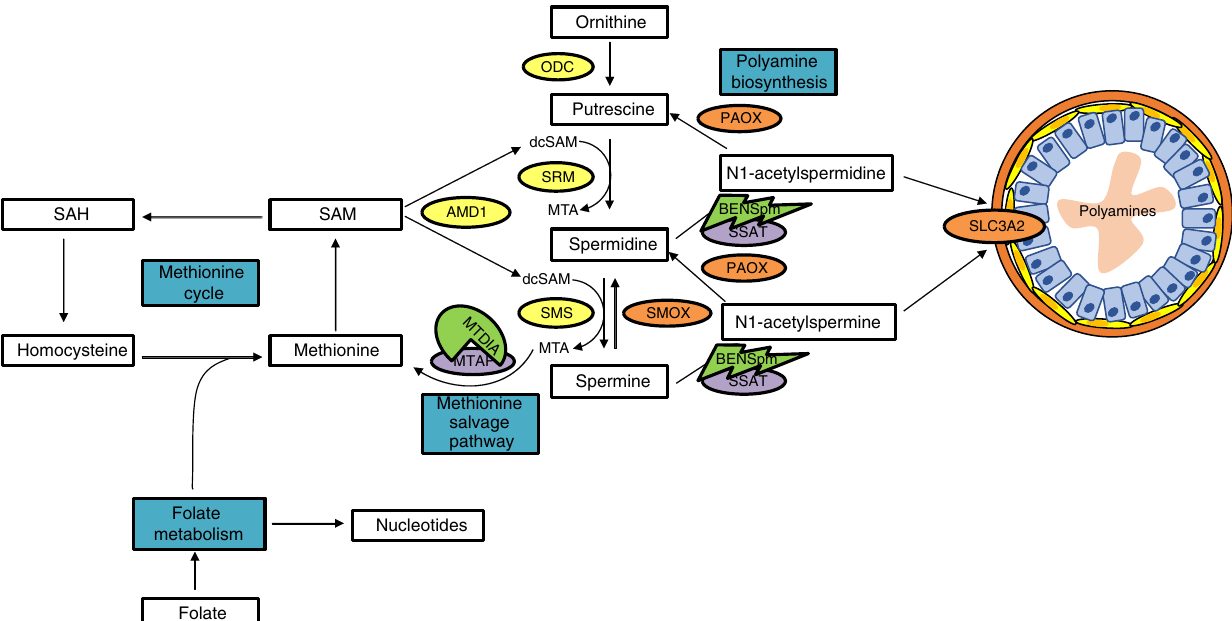
Fig. 1 Overview of BENSpm and MTDIA Therapeutic Approach. Pathways are highlighted in blue. Target Enzymes are highlighted in purple; methylthioadenosine phosphorylase (MTAP) and spermidine/spermine N 1 -acetyltransferase (SSAT). Pharmacological agents are highlighted in green and next to their corresponding target; Methylthio-DADMe-Immucillin-A (MTDIA) and N 1 ,N 11 -bisethylnorspermine (BENSpm). Poylamine biosynthesis enzymes are highlighted in yellow; ornithine decarboxylase (ODC1), s-adenosylmethionine decarboxylase (AMD1), spermidine synthase (SRM) and spermine synthase (SMS). The acetylated polyamine exporter is highlighted in pink; solute carrier 3 family member 2